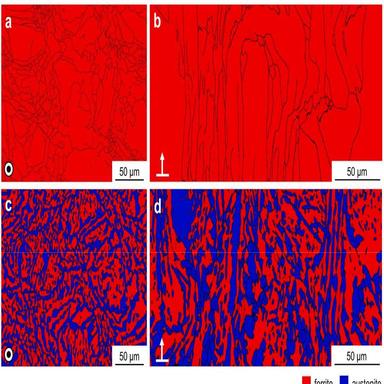
Phase maps of LPBF DSS 2205 taken from (a) AB build plane (b) AB build direction (c) HT build plane and (d) HT build direction (grain boundaries determined by misorientation of 5◦).